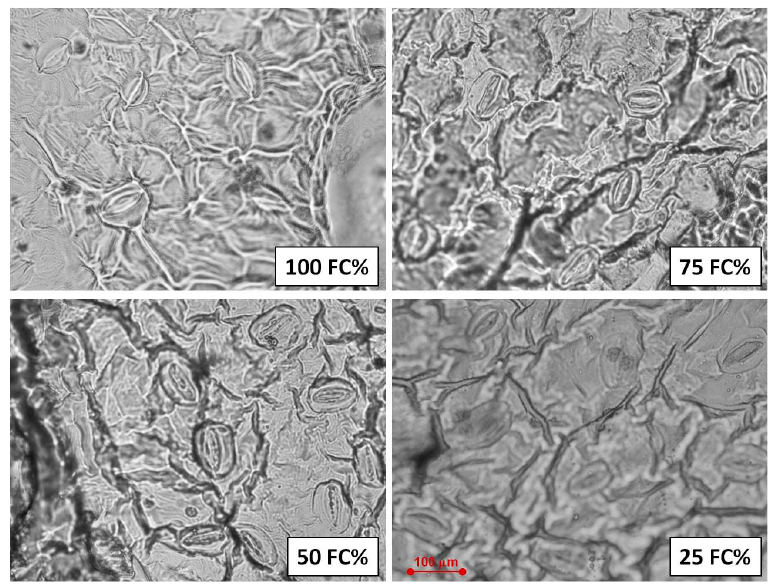
Figure 2. Light microscopy of leaf portions showing stomata traits in different drought stress treatments.